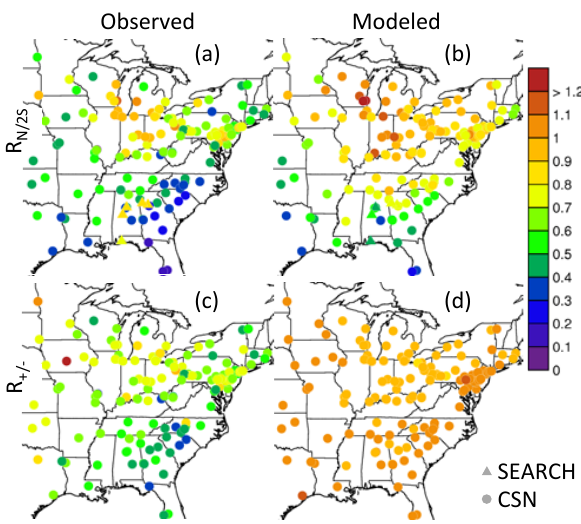
Figure 1. Molar ratios of aerosol ammonium to 2 × sulfate ( R N / 2S ) (a, b) and cations to anions ( R + / − ) (c, d) over the eastern US for 1 June–15 July 2013 based on observations and predicted by the CMAQ